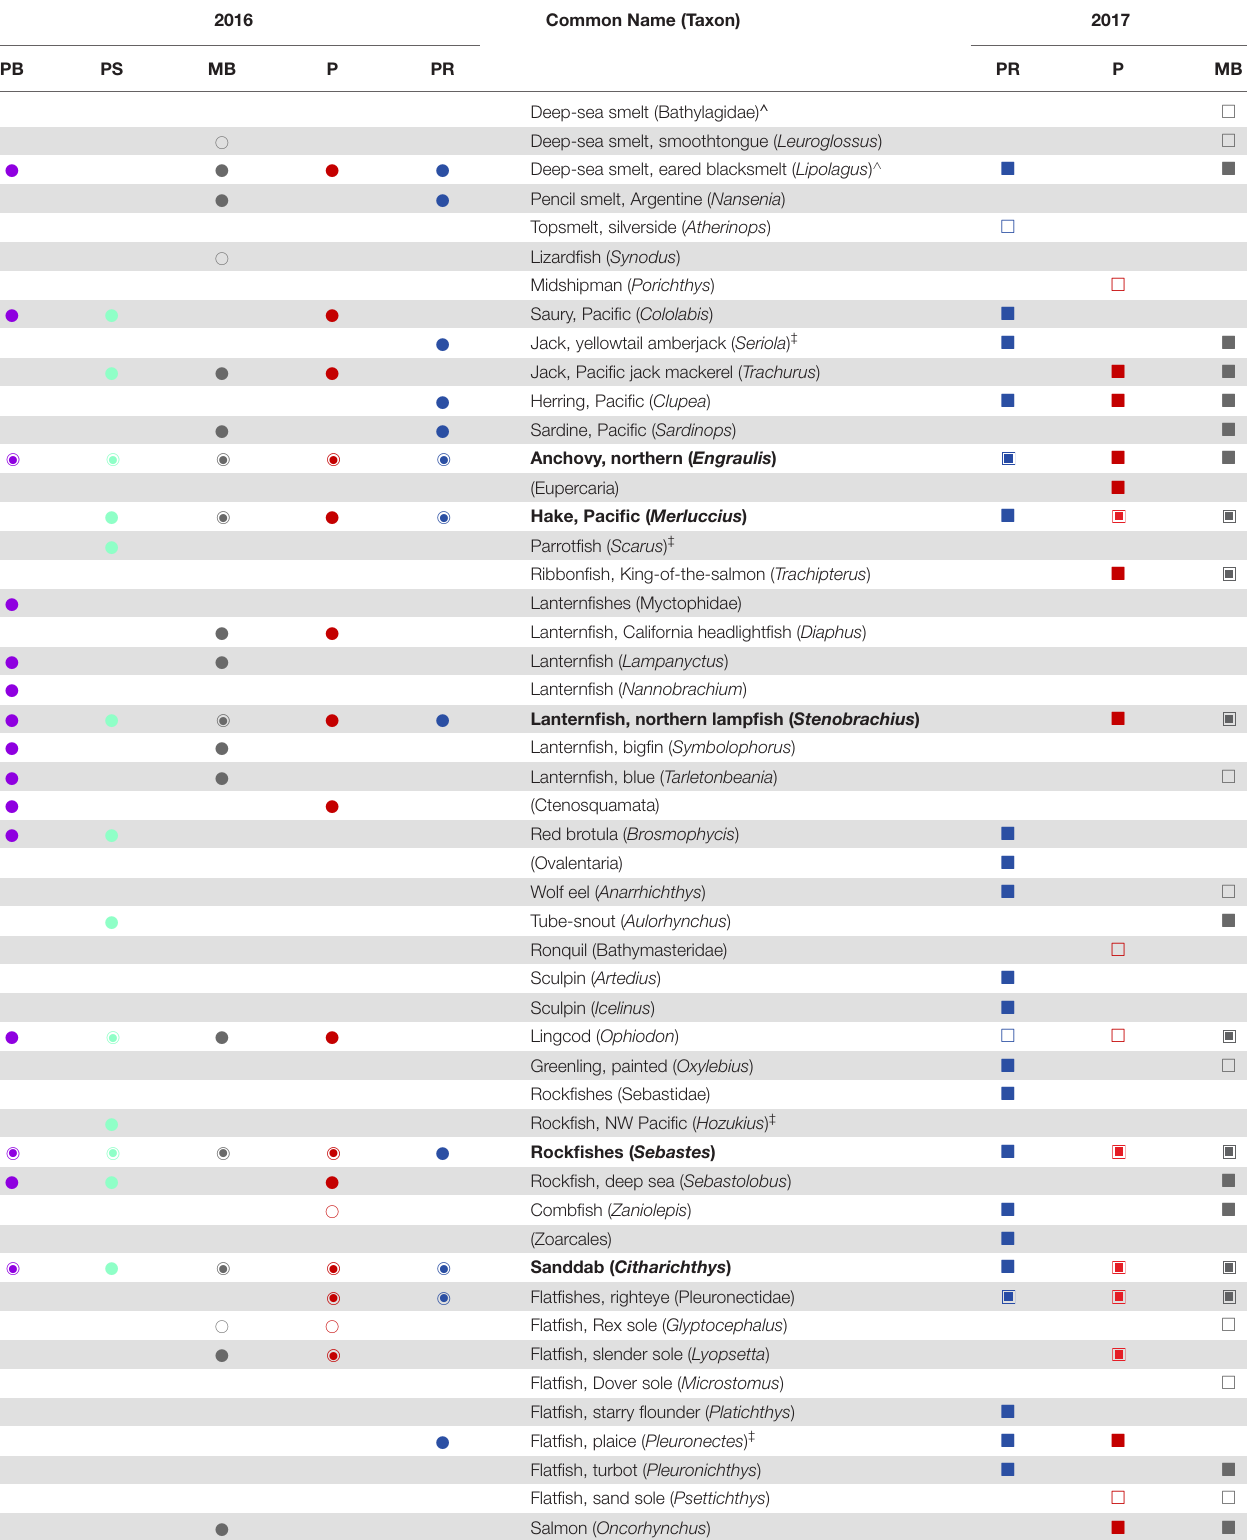
TABLE 1 | Taxa identified across Point Reyes (PR), Pescadero (P), Monterey Bay (MB), Point Sur (PS), and Piedras Blancas (PB) in 2016 (circles), and 2017